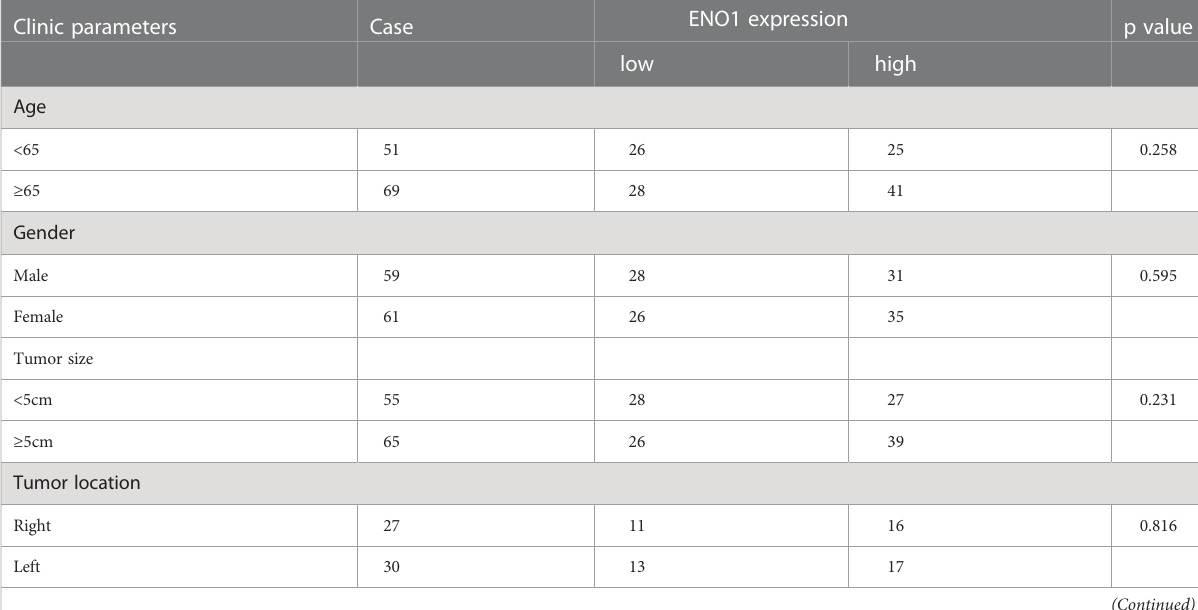
TABLE 1 Relationship between ENO1 and clinic-pathological factors in CRC patients.